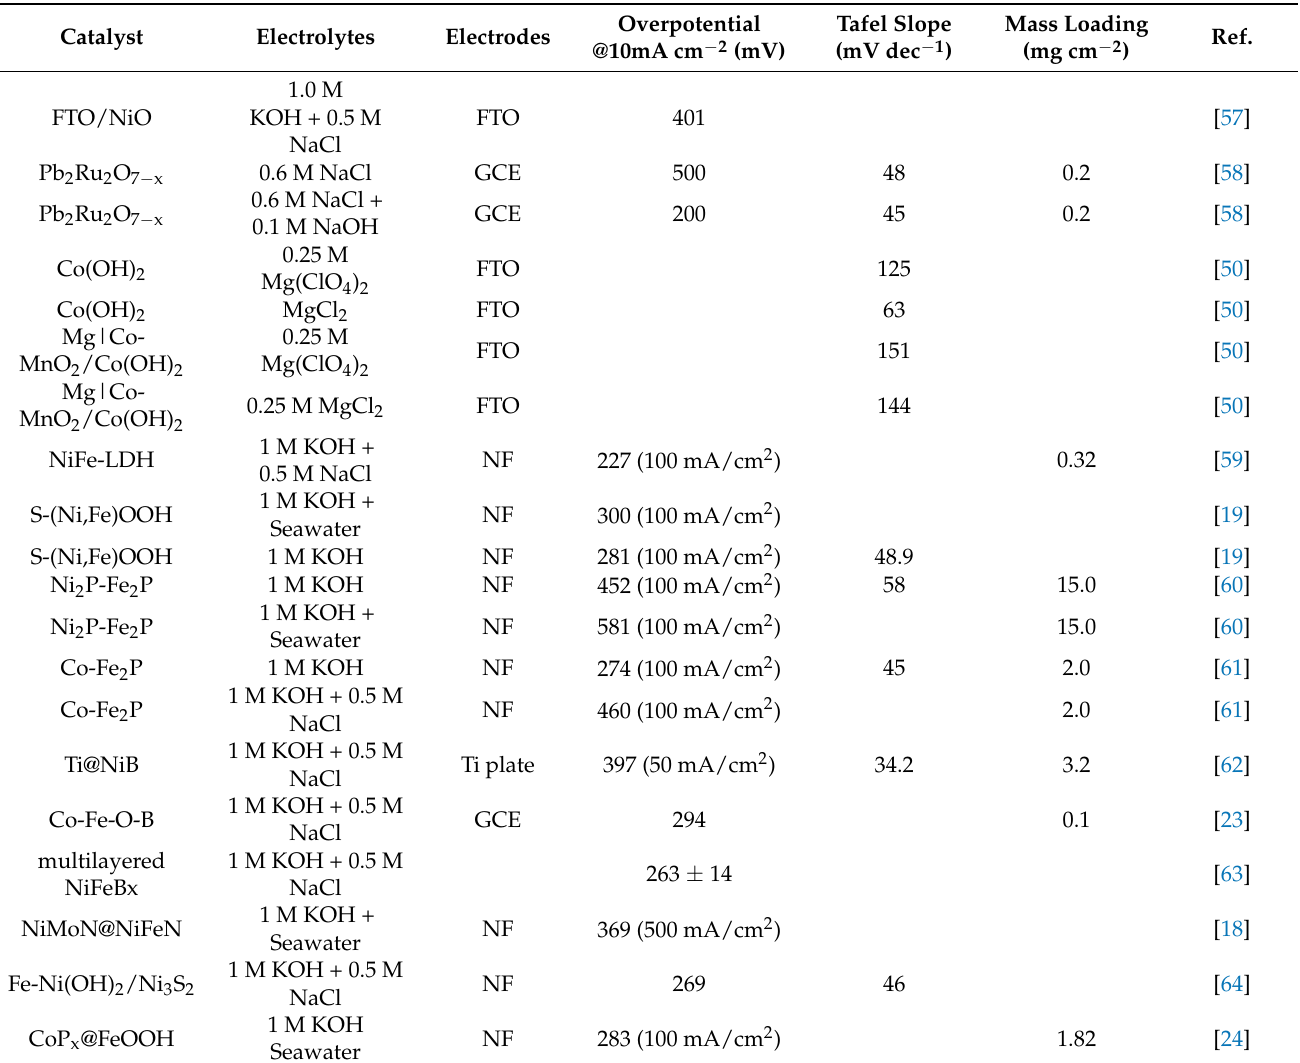
Table 1. Summary of OER performance of reported